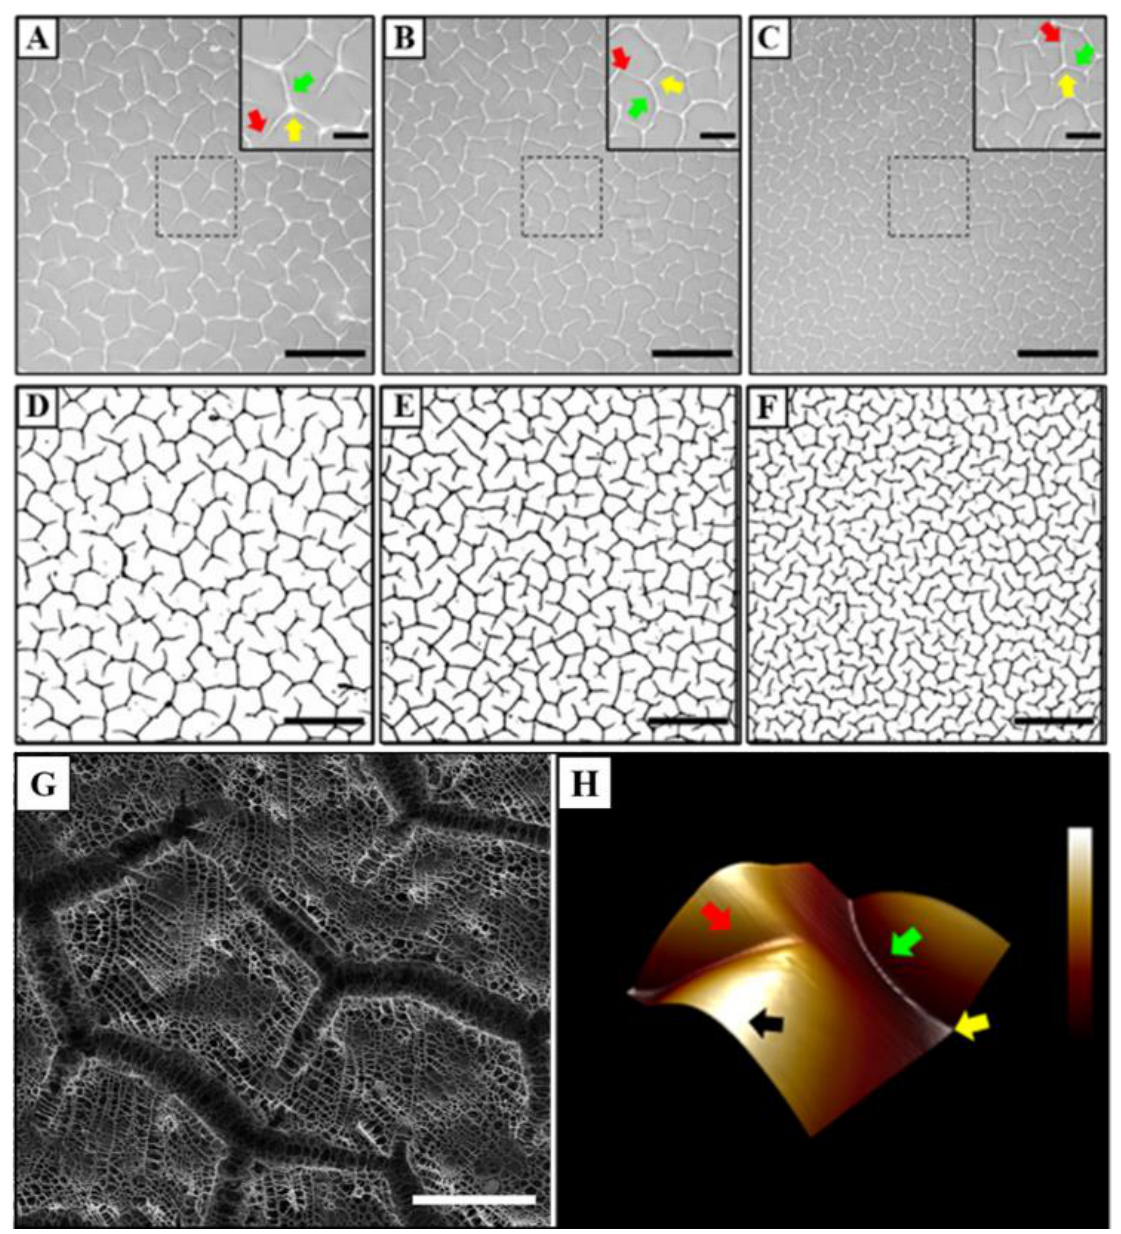
Figure 1. Topographical features of AZO-PA hydrogels. Phase-contrast images of creases on hydrogel surfaces formed with ( A ) ~100, ( B ) ~75 and ( C ) ~50 μm gel thickness (scale bar = 500 µm); binarized images of topographies on ( D ) ~100, ( E ) ~75 and ( F ) ~50 μm gel thickness (scale bar = 500 µm); ( G ) SEM image highlighting the surface creases at high magnification (scale bar = 250 µm); and ( H ) a 3D AFM map of the gel surface topography. Arrows indicate morphological components (red = disconnected branch; yellow = junction; and green = connected branch) and approximate force curve recording position (black) at convex surface region amenable to probe engagement.